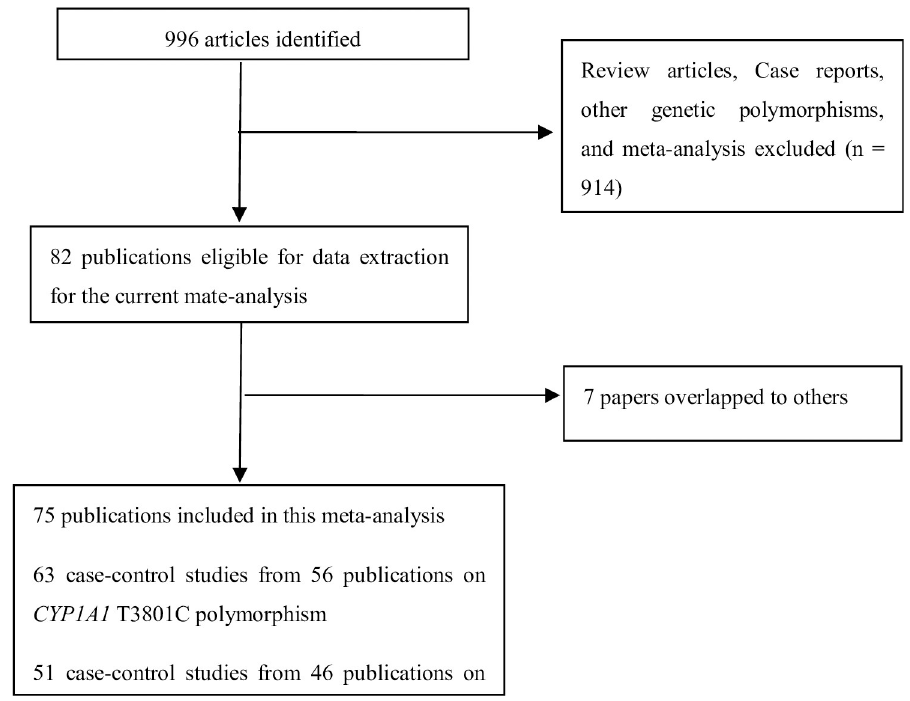
Fig 1. Flow diagram for identifying and including studies in the current